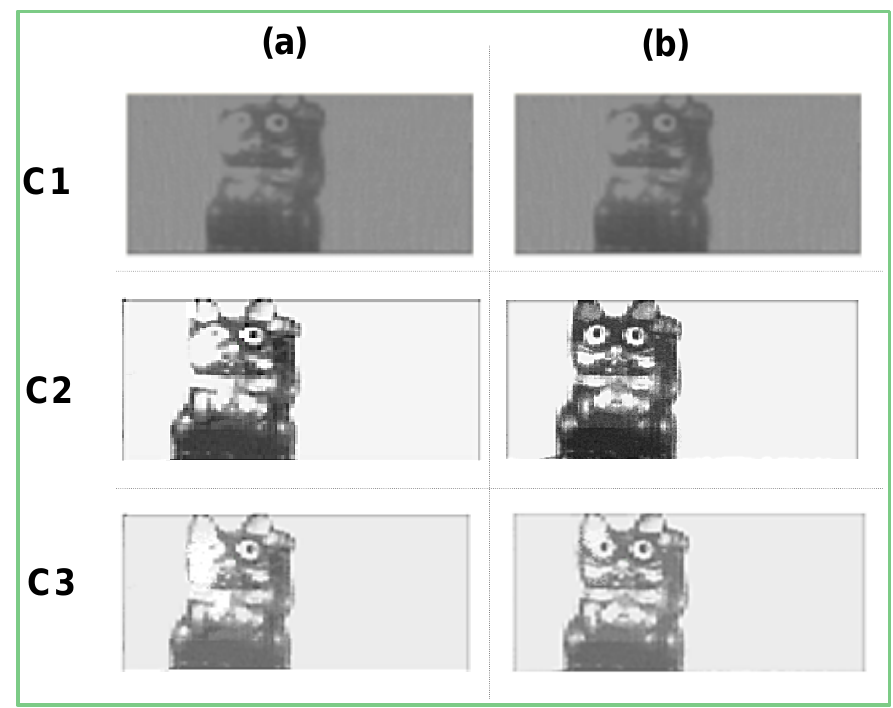
Figure 9. ( a ) Saturated images at points C1, C2, and C3; ( b ) WDR images at points C1, C2, and